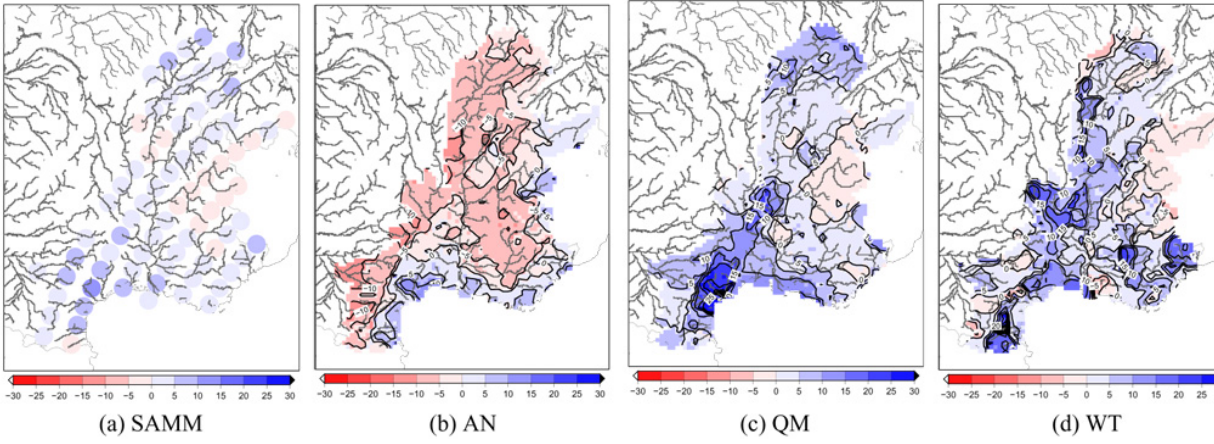
Fig. 6. Anomaly (2035–2064 vs. 1970–1999) of PQ95 (in